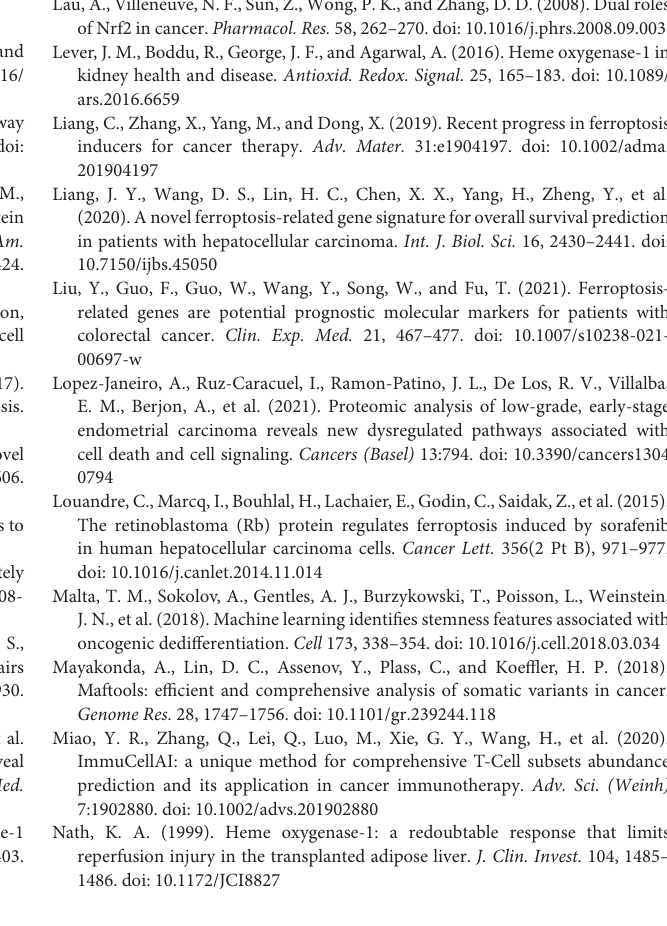
Supplementary Figure 2 | Kaplan–Meier plot of the high- and low-risk groups under diverse situations by classifying the patients into different subgroups according to (A) age, (B) tumor grade, (C) tumor pathological pattern, and (D) stage. Supplementary Figure 3 | m6A regulators, mRNAsi, and functional analyses in two groups. (A) The expression levels of HNRNPC, YTHDC1, ZC3H13, YTHDF2, FTO, YTHDF1, YTHDF3, METTL14, RBM15, WTAP, KIAA1429, FMR1, and HNRNPA2B1 were dramatically higher in UCEC high-risk group than in low-risk group. (B) The expression levels of mRNAsi and EREG-mRNAsi in high-risk and low-risk groups. (C) The correlation between the FRPS and scores of 16 immune cells determined by ssGSEA. (D) The enriched cytokine–cytokine receptor interaction determined by ssGSEA. The low-risk and high-risk groups are represented via blue and red violin, respectively. Supplementary Figure 4 | Significantly enriched KEGG pathway related to FRPS identified by GSEA analysis. Supplementary Figure 5 | The predicted chemotherapeutic response in the high-risk and low-risk groups. Supplementary Table 1 | The basic clinical information of the involved patients in TCGA. Supplementary Table 2 | Primers used in PCR application. Supplementary Table 3 | The correlation between the signature and clinical